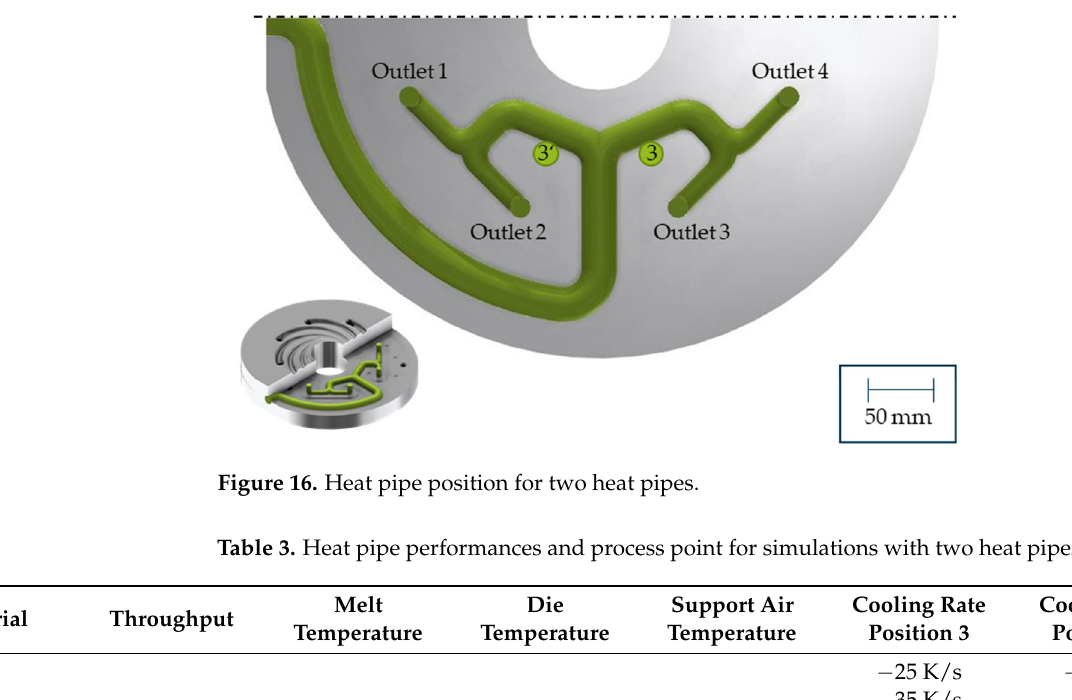
Table 3. Heat pipe performances and process point for simulations with two heat pipes.